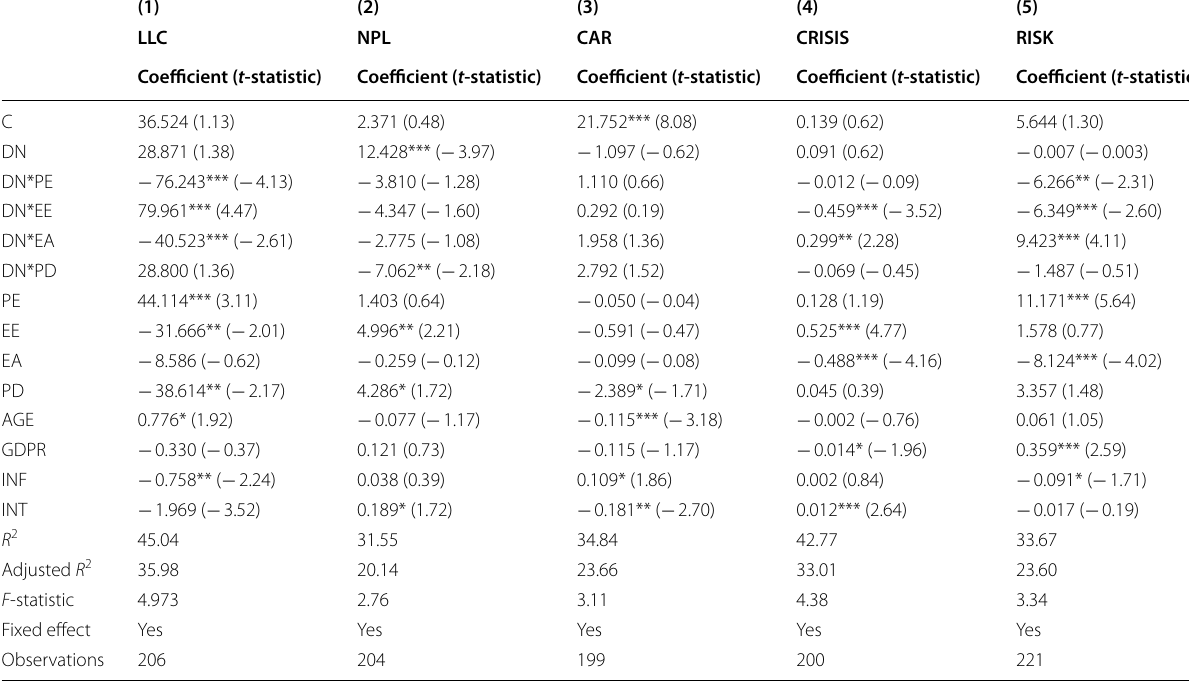
The results in this table are estimated using fixed-effect regression. Only period fixed effect was applied ***, **, * represent significance at 1%, 5%,